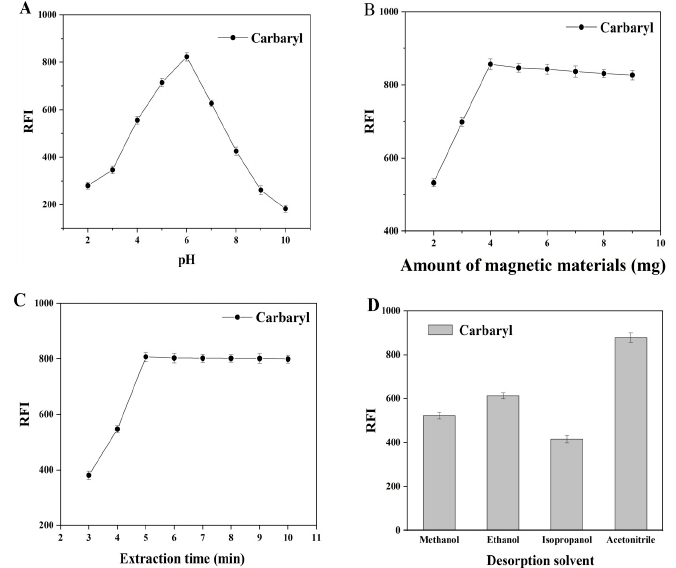
Figure 2. Optimization of the MSPE method (50 mL of sample solution, c = 100 ng·mL − 1 , n = 3): ( A ) effect of sample solution pH; ( B ) effect of adsorbent amount; ( C ) effect of the extraction time; and ( D ) effect of desorption solvent type.